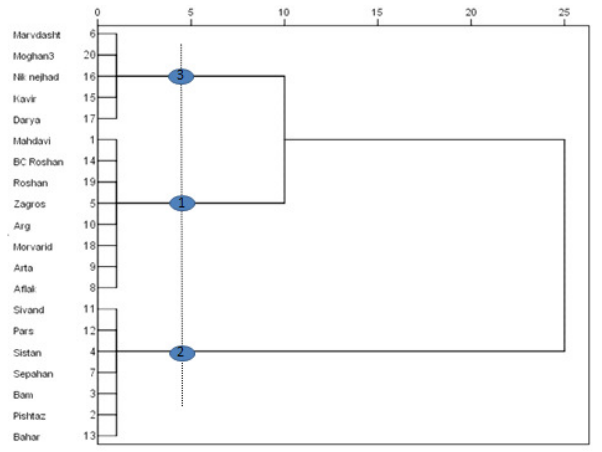
Fig. 2. Dendrogram obtained based on the factors under drought